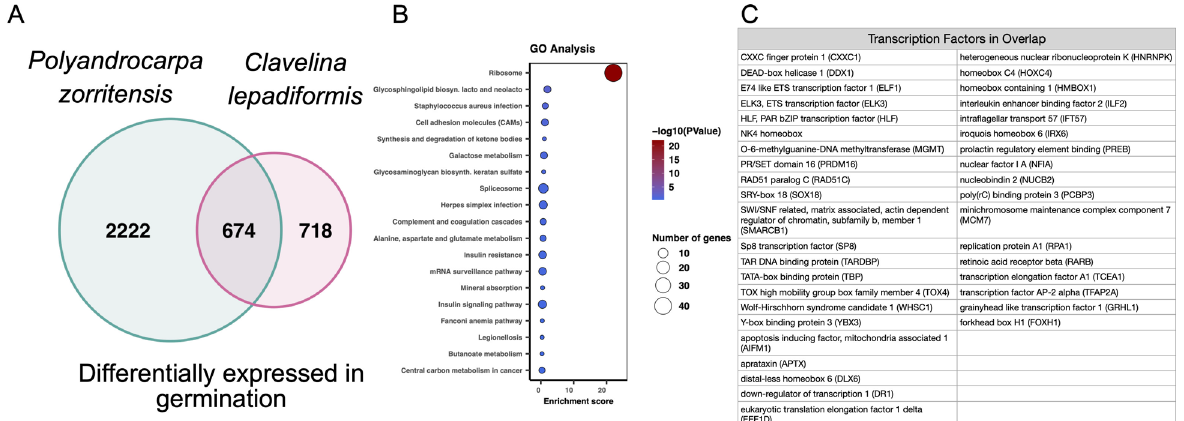
Figure 11. Shared up-regulated transcripts and pathways during germination in P. zorritensis and C. lepadiformis. ( A ) Venn diagram showing the number of orthologous upregulated transcripts during germination in P. zorritensis and C. lepadiformis . ( B ) KEGG pathway terms enriched in the overlapping set of 674 transcripts upregulated in both species. ( C ) Transcription factors upregulated in germination in both